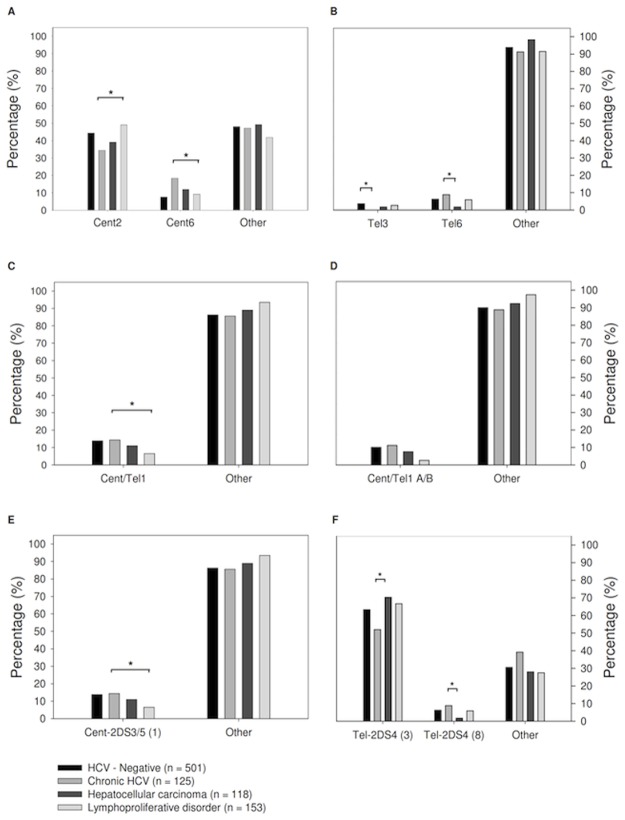
Cent/Tel KIR gene profiles in HCV-negative patients and patients with HCV infection and different outcomes.Distribution of Cent2 and Cent6 locus (panel A, Table 2). Distribution of Tel3 and Tel6 loci (panel B, Table 2). Distribution of Cent/Tel1 loci (panel C, Table 2). Distribution of Cent/Tel1 with A/B KIR2DL5 variant (panel D, Table 3). Distribution of Cent-2DS3/5 (1) loci (panel E, Table 3). Distribution of Tel-2DS4 (3) AND Tel-2DS4 (8) locus (panel F, Table 3). * Fisherx’s Exact test, p<0.05.